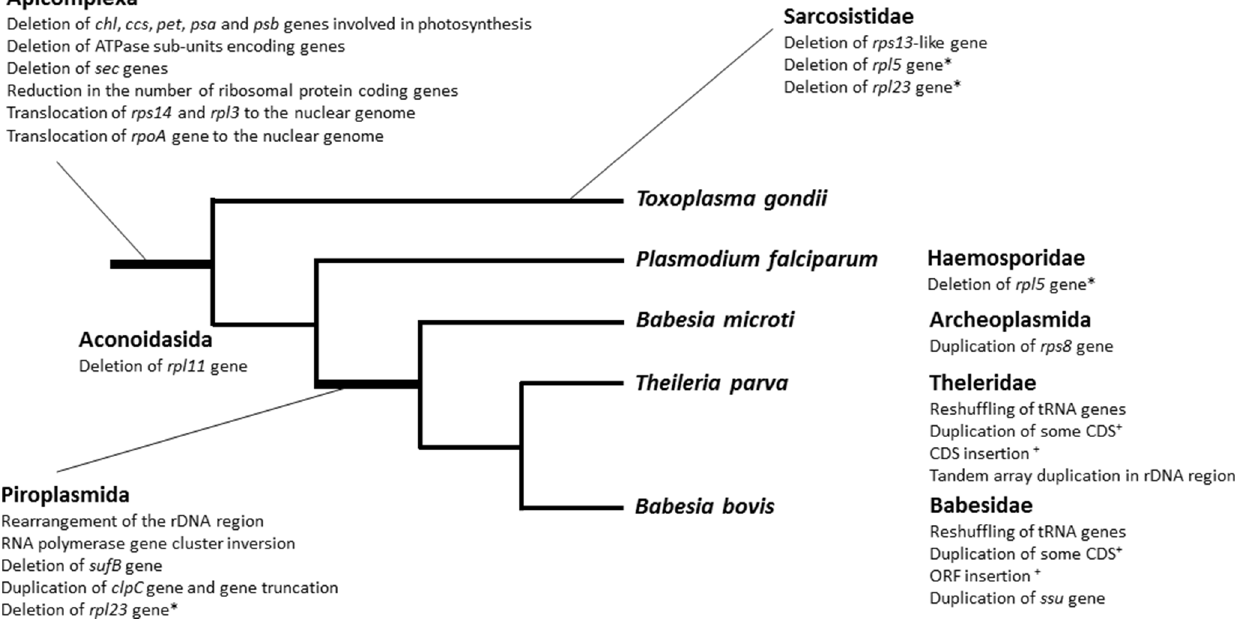
Figure 7. Summary of the evolution of the organization of the apicoplast genome in apicomplexan parasites. The unweighted tree was built using raw data from Figure S2 in File S1. The branch supporting the clade piroplasmida is associated with several major genomic rearrangements. *: events that occurred twice in the apicoplast evolution; + : rearrangement, duplication and insertion events observed in B bovis and T. parva involving distinct genes.